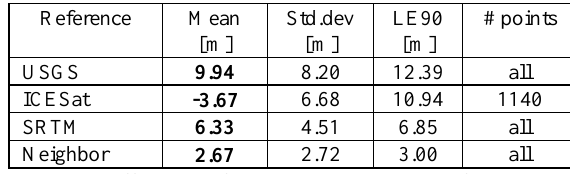
Table 2: Differences of IDEM tile N39W79 to reference data (mean, standard deviation, linear 90% point-to-point error, number of points)